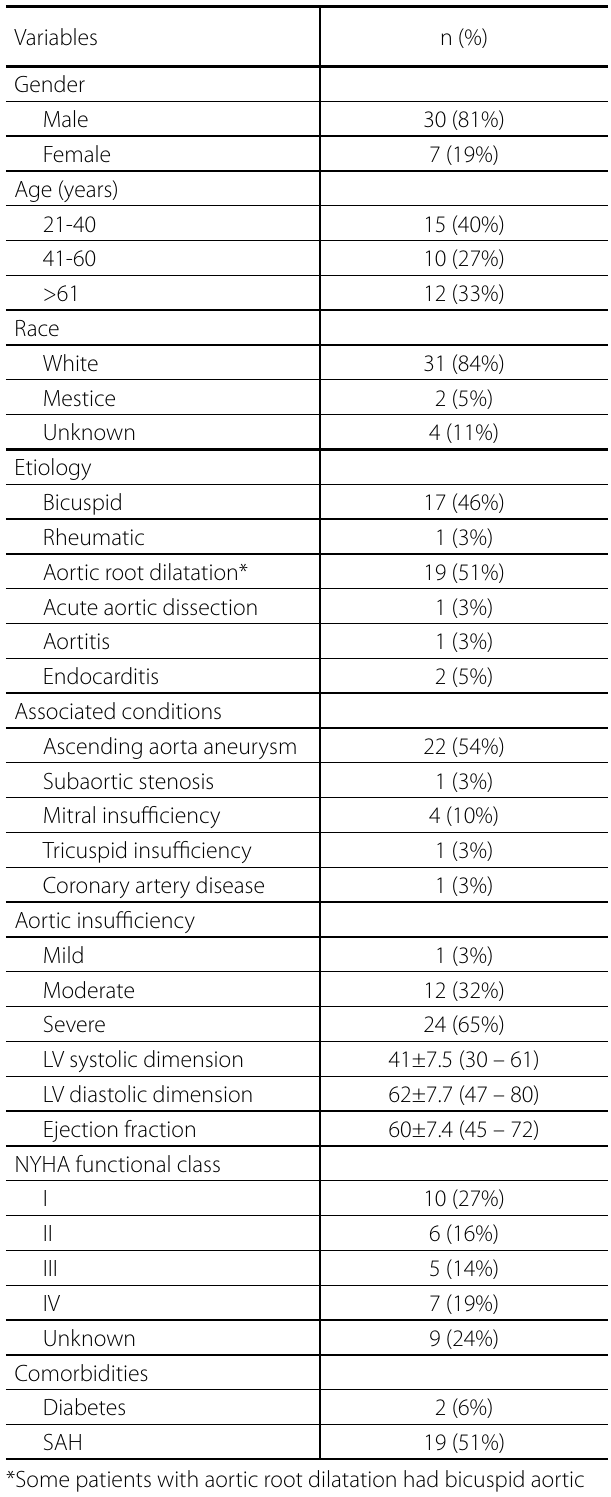
Table 1. Demographic data and clinical